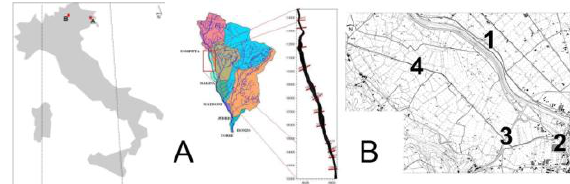
Figure 1. Location of the study areas: Reach of the river Torre (A) studied with the MIKE 21C simulations and Adige floodplain (B) studied with the SOBEK model (1. Adige River; 2. pumping station; 3. road embankment; 4. drainage channel) The river Torre rises in the Italian Dolomites (north-east Italy) and flows for 66 km until it ends at the confluence with the river Isonzo. Its braided riverbed is formed of central islands partially covered with vegetation and extended floodplain areas, often used for agriculture.